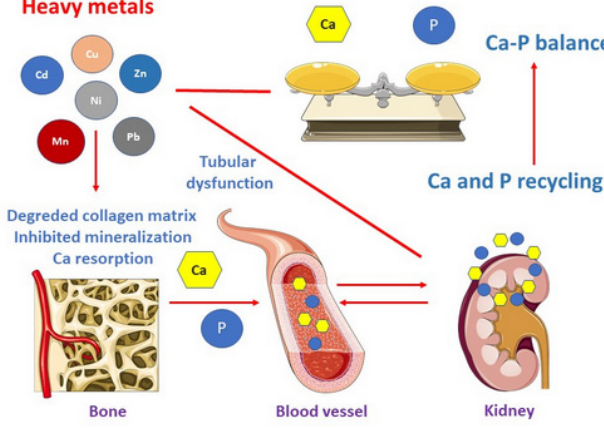
Figure 1. The effects of toxic metals.